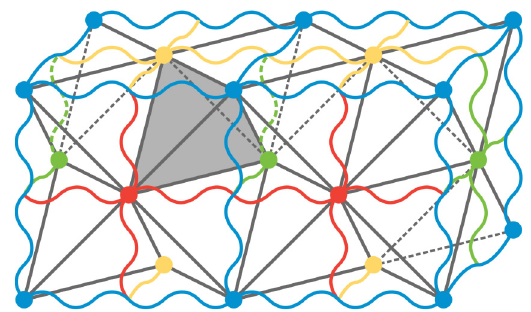
FIG. 16. A portion of the morphed BNB lattice. The gray edges show the underlying tetrahedral-octahedral lattice. We have one qubit for each edge linking vertices of the same color and one qubit for each tetrahedron (one of which we shade in gray). X -type stabilizer generators are associated with vertices and Z -type stabilizer generators are associated with edges linking vertices of different colors.